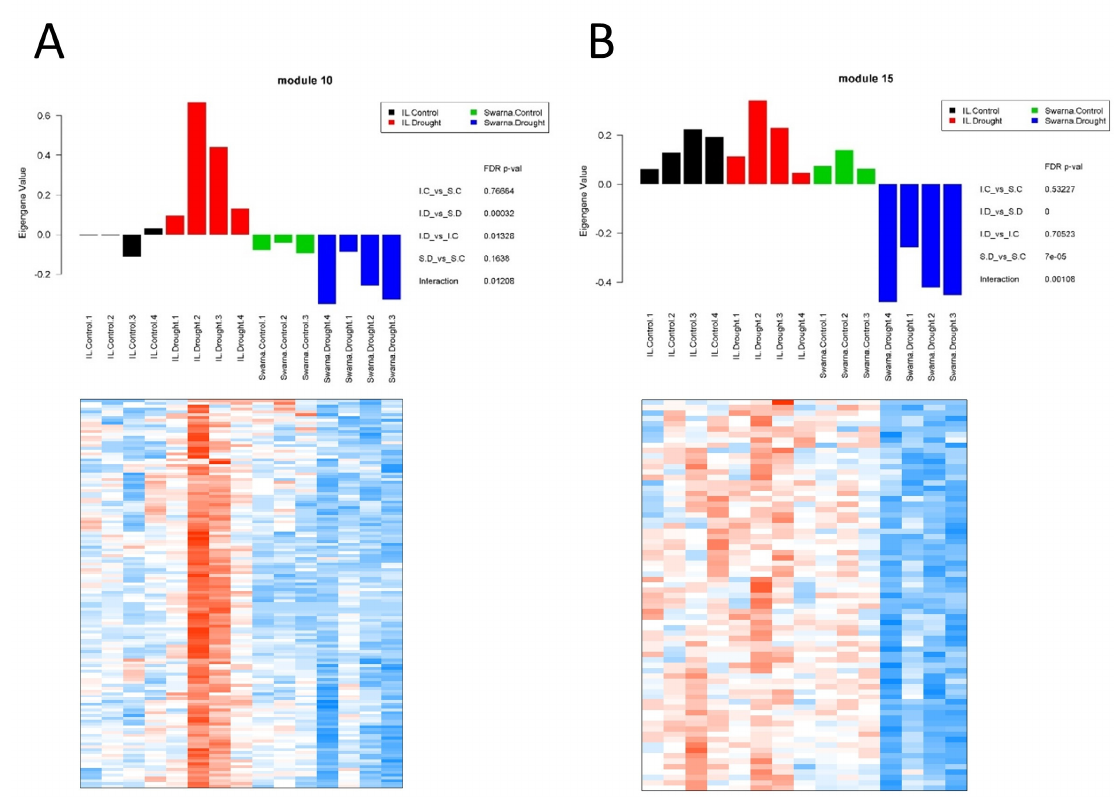
Figure 7. Gene co-expression network analysis in panicle under RDS. Bar plot of the module eigengene as representatives of the gene expression profiles across di ff erent samples in P-M10 (module 10) ( A ) and P-M15 (module 15) ( B ). X -axis represents 15 di ff erent samples across four di ff erent groups, while Y -axis corresponds to the eigengene value. Heatmaps showing gene expression levels of genes in P-M10 and P-M15. Columns represent samples, while rows correspond to genes in the module. Red indicates positive and blue negative expression profile. S.C = Swarna control, S.D = Swarna under RDS, IL.C = DTY-IL control, IL.D = DTY-IL under RDS.